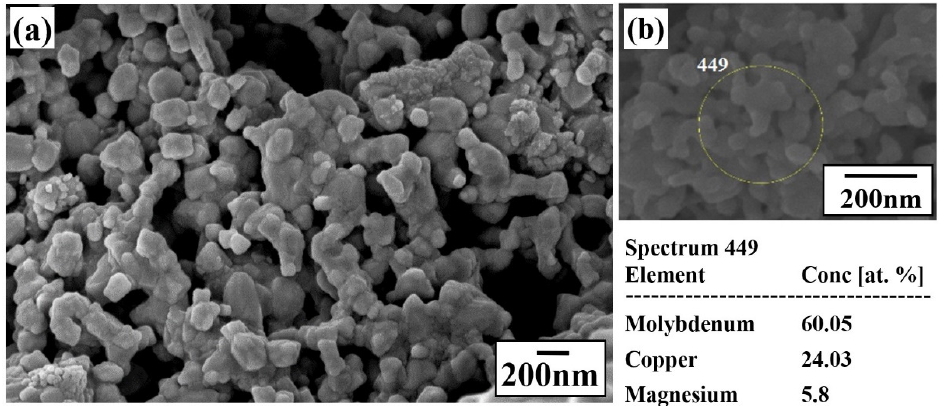
Figure 14. SEM/EDS analyses of the Mo-Cu quenched sample at 1573 K, ( a , b